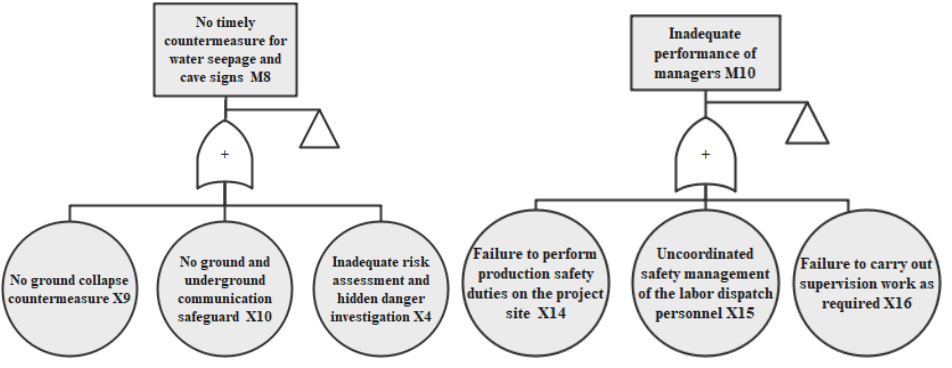
Figure 4. Fault tree diagram of the “12.1” major cave ‐ in accident.